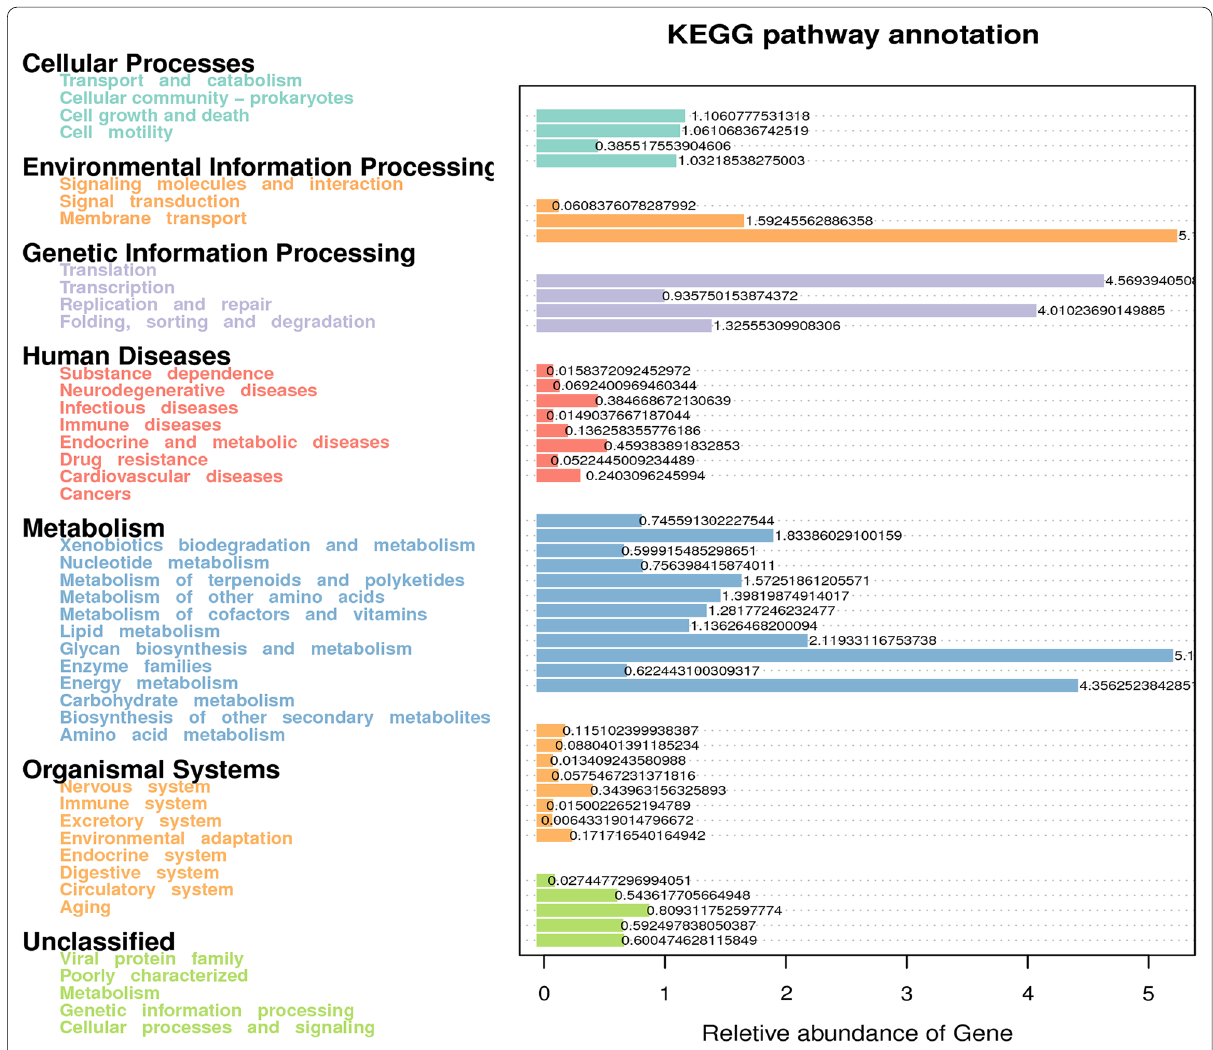
Fig. 5 KEGG pathway annotation of short-faced moles gut